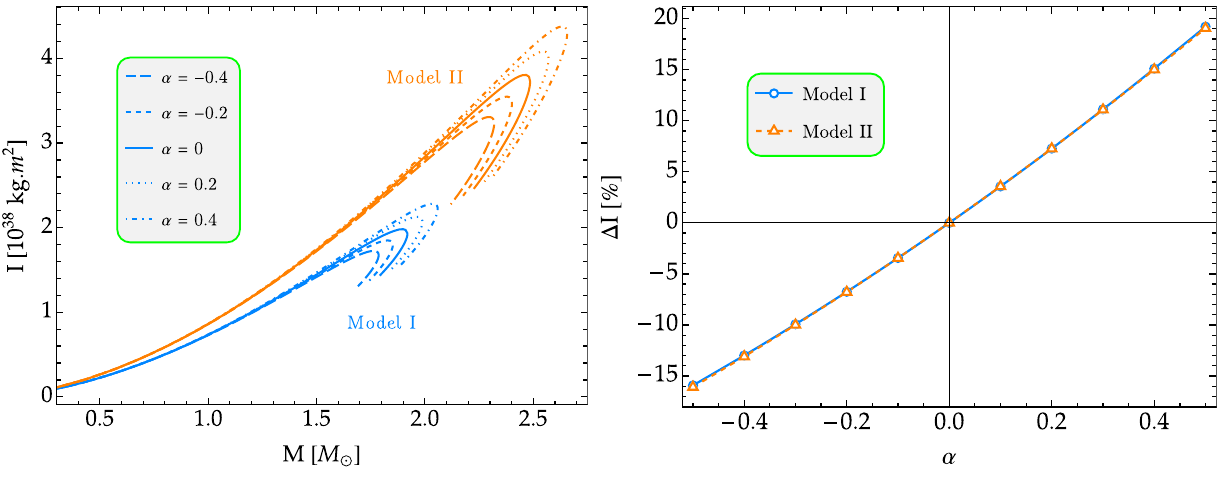
Fig. 8 Left panel: Moment of inertia versus mass for anisotropic dark energy stars, where a higher mass results in larger moment on inertia for both models. It is observed that the substantial impact of anisotropy on the moment of inertia occurs predominantly in the high-mass branch.